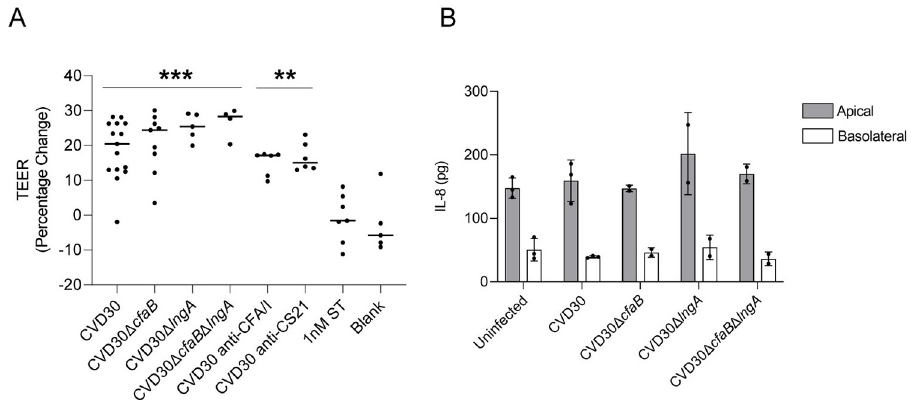
Fig 10. The effect of CFA/I-CS21 ETEC infection on barrier integrity and cytokine induction in ileal enteroid responses. TEER values of differentiated ileal enteroid monolayers (35I) were recorded prior to and after 4 hr infection (A). The change in TEER over time is expressed as TEER (percentage change) and data presented are pooled from six independent experiments. The asterisks above the dots indicate statistically significant differences determined using one-way ANOVA with Bonferroni’s multiple-comparison test, compared to the TEER of the uninfected enteroid monolayers (Blank). �� , p < 0.01; ��� , p < 0.001. IL-8 secretion (pg) was measured following 8 hr infection of enteroid monolayers (35I) by wildtype CVD30 and its derivative CF-deficient mutant strains, and data presented are from one independent experiment (B). Each dot represents data collected from an individual monolayer. Statistically significant differences were calculated using one-way ANOVA with Bonferroni’s multiple-comparison